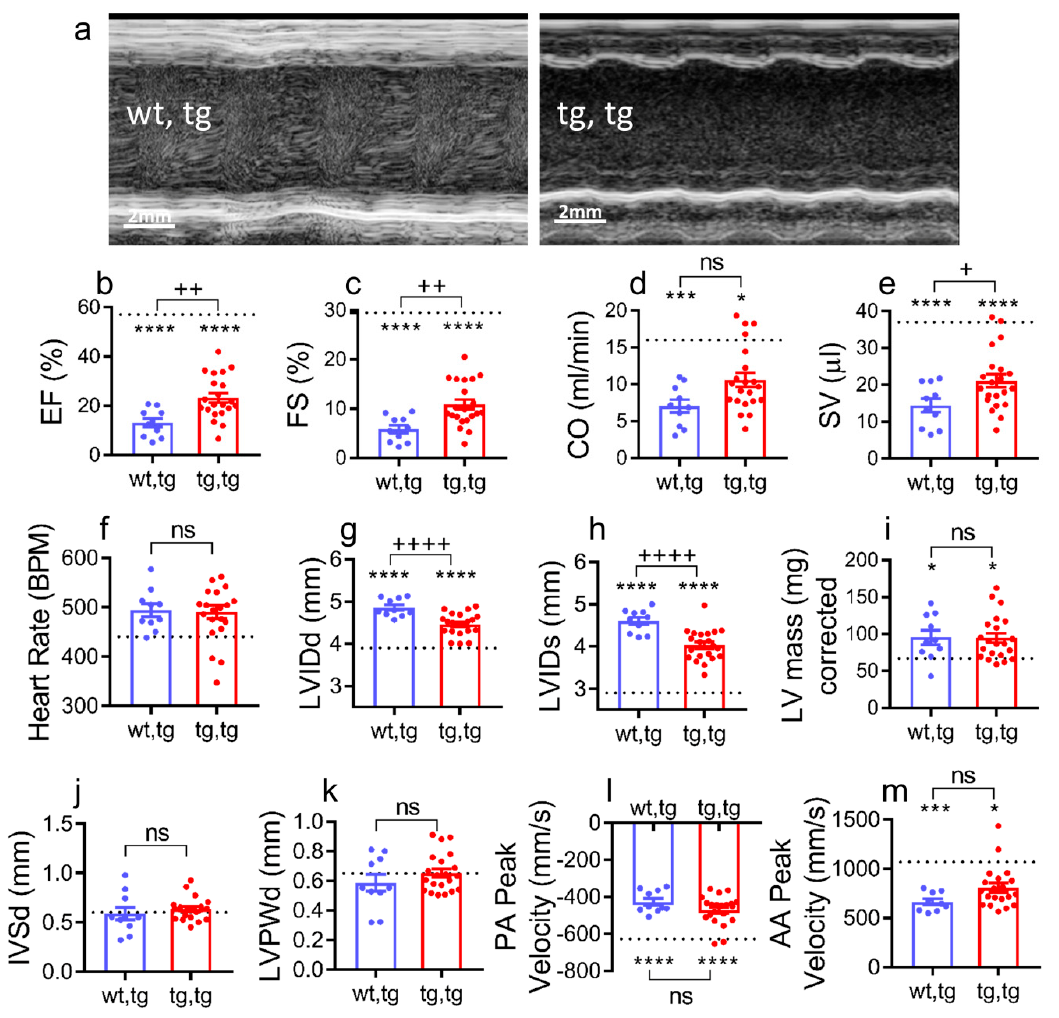
Figure 4. Cardiac corin-Tg(i) overexpression improves systolic function in female mice with DCM. ( a ) Representative two-dimensional guided left ventricular short axis M-mode images, ( b ) ejection fraction (EF), ( c ) fraction shortening (FS), ( d ) cardiac output (CO), ( e ) stroke volume (SV), ( f ) heart rate (beats per minute), ( g ) left ventricular internal diameter in diastole (LVIDd), ( h ) left ventricular internal diameter in systole (LVIDs), ( i ) LV mass, ( j ) interventricular septal wall thickness in diastole (IVSd), ( k ) left ventricular posterior wall thickness in diastole (LVPWd), ( l ) pulmonary artery (PA) peak velocity, and ( m ) ascending aorta (AA) peak velocity in all experimental groups. Experimental groups were mice at 90 days of age: Corin-Tg(i)/DCM ( ● , tg,tg, n = 21) and corin-WT/DCM ( ● , wt,tg, n = 10), and dotted line represents normal control values in corin-WT/WT (wt,wt, n = 7). Statistical differences in all panels among three groups were analyzed by one-way ANOVA using Newman–Keuls multiple comparisons test except in ( d , i , k , m ) where Kruskal–Wallis test using Dunn’s multiple comparisons test were used. Data are represented as mean ± SE; **** p < 0.0001, *** p < 0.001, * p < 0.05 (tg,tg or wt,tg vs. wt,wt); ++++ p < 0.0001, ++ p < 0.01, + p < 0.05 (tg,tg vs. wt,tg); ns = not significant.